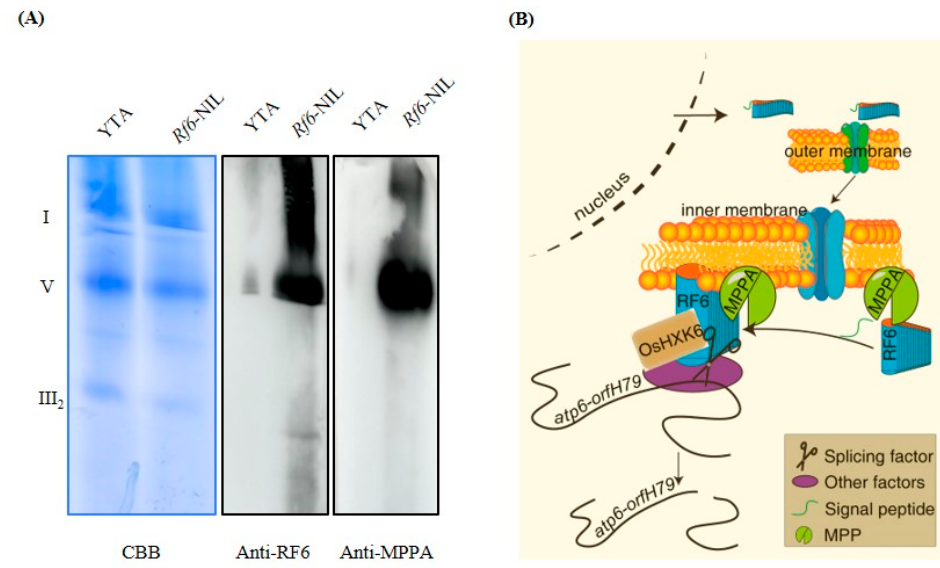
Figure 6. MPPA is indispensable for the RF6 fertility restoration complex. ( A ) The blue-native PAGE (BN-PAGE) analysis of the mitochondrial protein complex. Anti-RF6 and anti-MPPA were used for detecting the RF6 fertility restoration complex in YTA and Rf6 -NIL, respectively. ( B ) An updated version of the working model of the RF6 fertility restoration complex. Upon translocation, the signal peptide of RF6 protein was removed by the MPP complex, and the alpha subunit (MPPA) of the MPP complex interacted with the RF6 to help it anchor into the inner membrane of mitochondria. The CMS-associated atp6-orfH79 was cleaved after the assembly of the RF6 fertility restoration complex. Then the fertility was restored in Honglian-CMS rice.